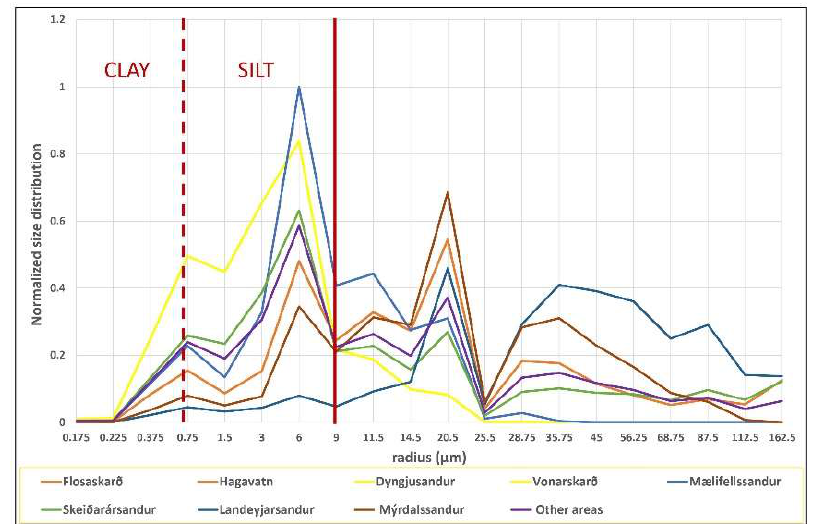
Figure 4. Normalized model particle size distributions at measurement sites. Clay and silt particle size domains are indicated with vertical dark red lines. The distributions at Flosaskarð and Hagavatn are the same. Dyngjusandur and Vonarskarð have the same distributions as well.